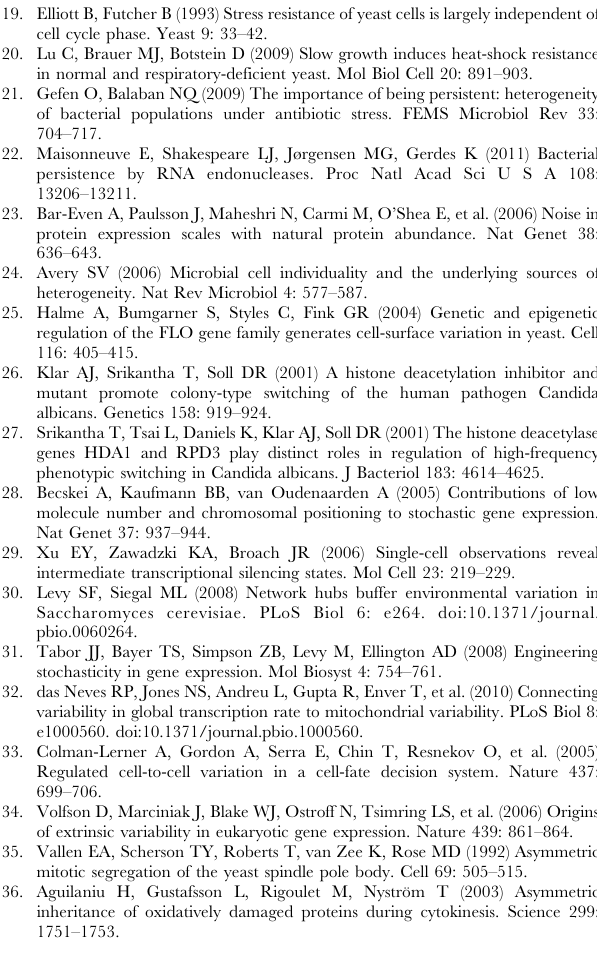
Video S3 A highly fluorescent slow-growing cell produces low- fluorescence fast-growing progeny. Bright-field (bottom) and fluorescent (top) images of TSL1 -GFP yeast grown for 9 h. Notice that slow-growing cells on the right produce fast-growing progeny. (MOV) Video S4 Typical results of heat killing. Bright-field (left) and fluorescent (right) images of TSL1 -GFP yeast grown for 5 h, heat shocked, and grown for another 13